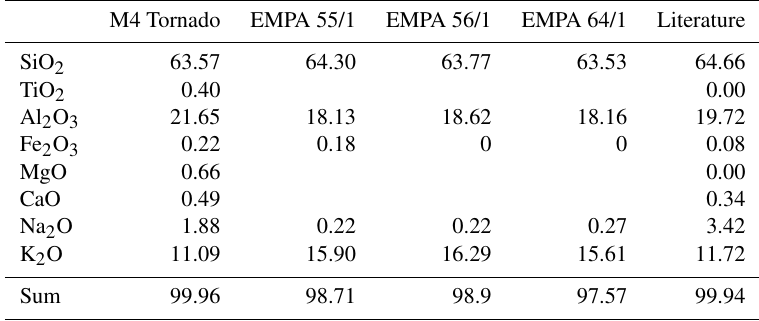
Table 2. M4 Tornado chemical analysis of a K-feldspar spectrum from Fig. 1, EMPA from three different spots on K feldspar and literature value from Deer et al.